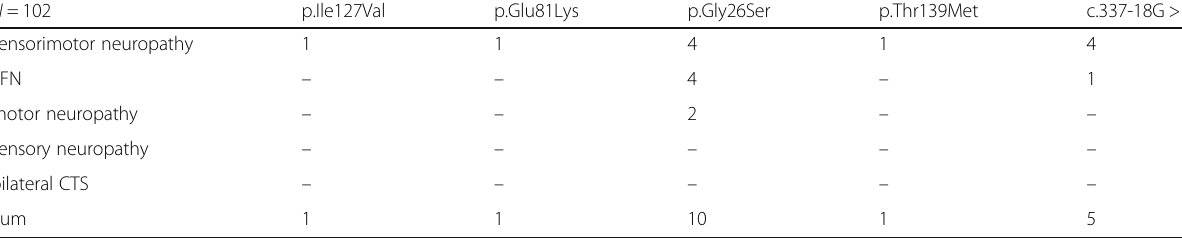
Table 1 TTR gene variants detected in 102 patients with polyneuropathy N =